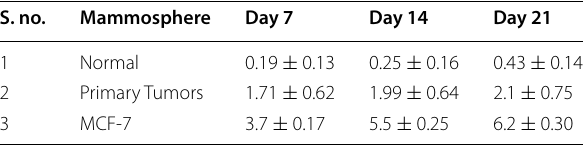
Table 2 Mammosphere-forming efficiency of stem-like cells isolated from normal breast tissues, primary tumors and MCF-7 cell line in increasing passages S.